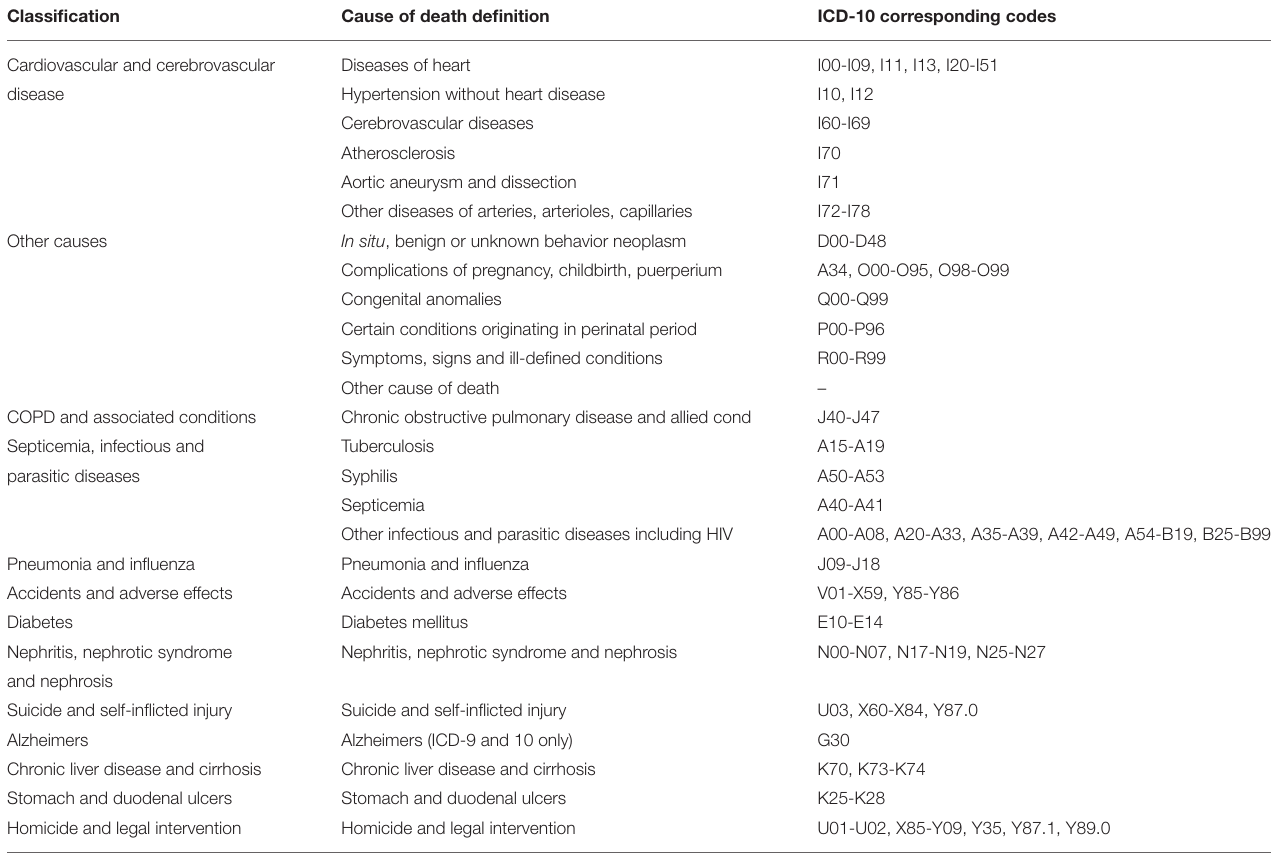
TABLE 1 | The classification of non-cancer causes in the present study.